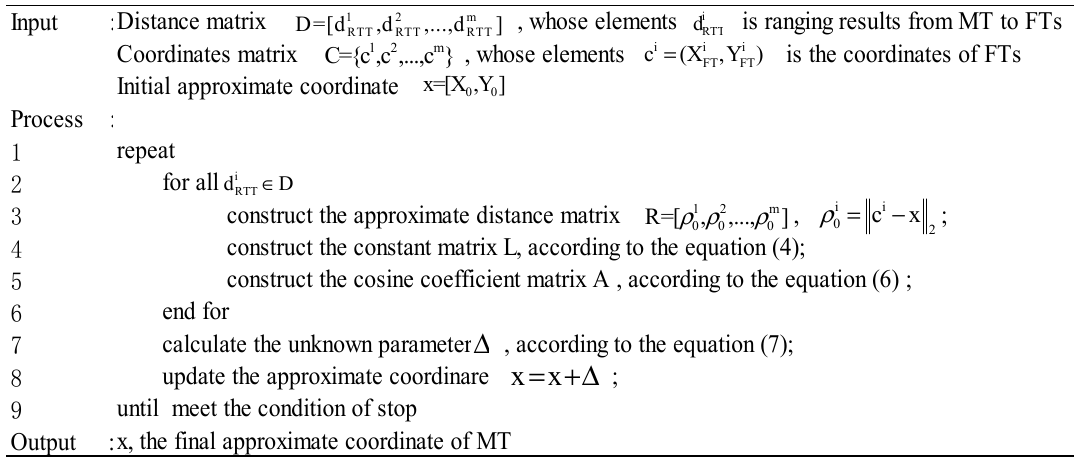
Figure 9. Single point positioning algorithm.